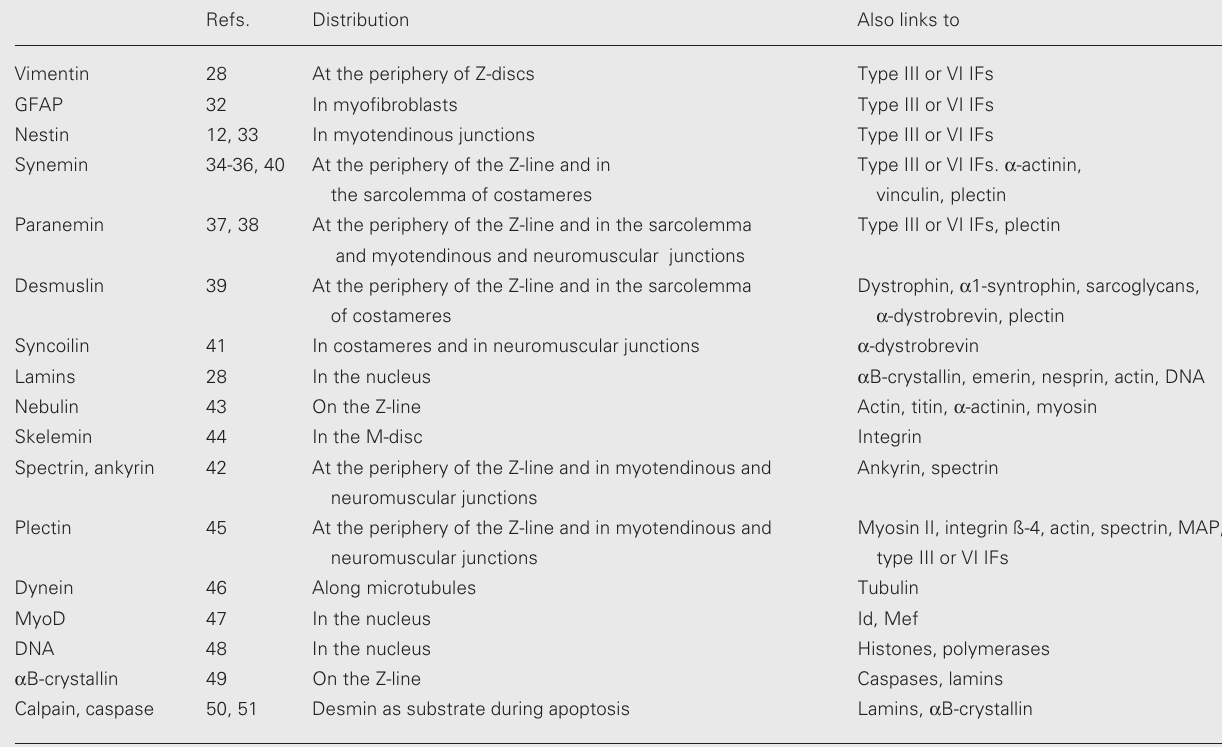
Table 1. Macromolecules that interact with desmin.